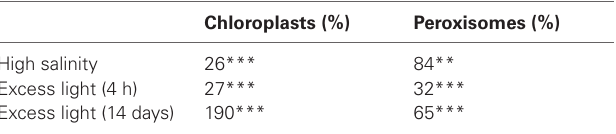
Table 2 | Changes in the subcellular distribution of glutathione in Arabidopsis Col-0 plants exposed to salt stress (treatment of plants with 100 mM NaCl for 3 days; unpublished data) and excess light conditions (700 µ mol m − 2 s − 1 light for 4 h and 14 days; data according to Heyneke et al., 2013) when compared to plants grown at 150 µ mol m − 2 s − 1